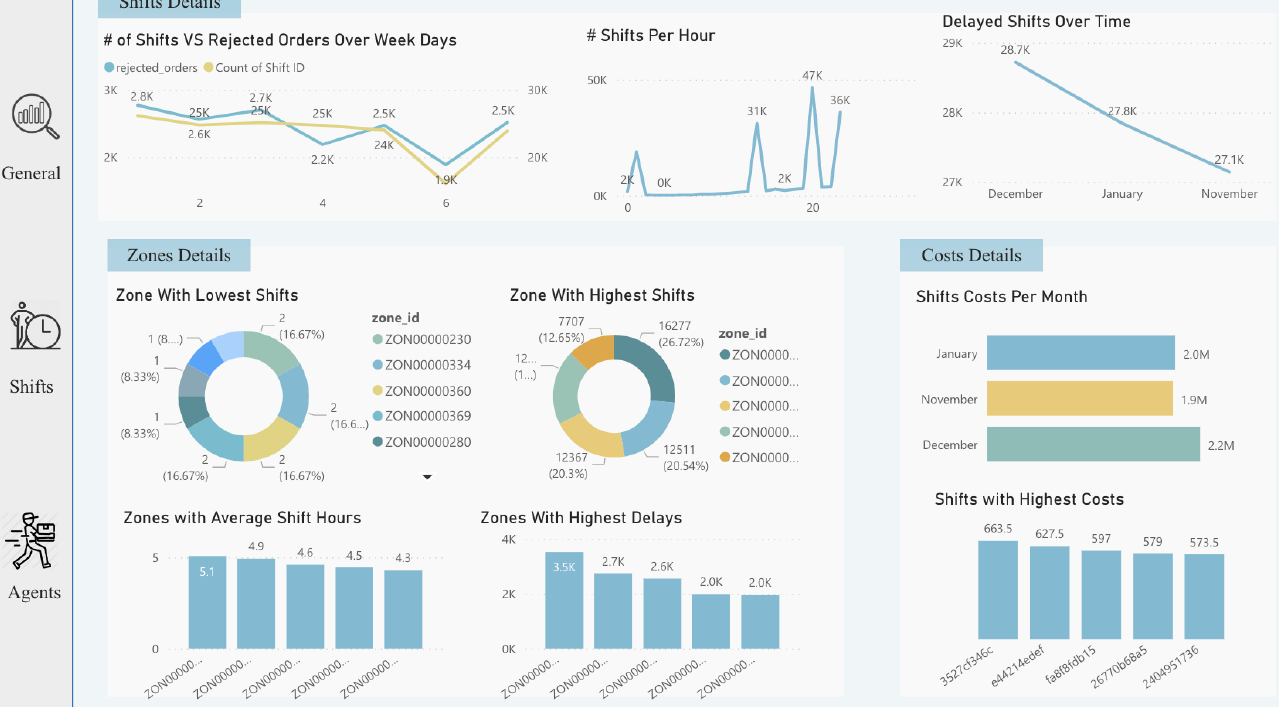
Figure 12. Dashboard (shifts tab) designed after analysis.